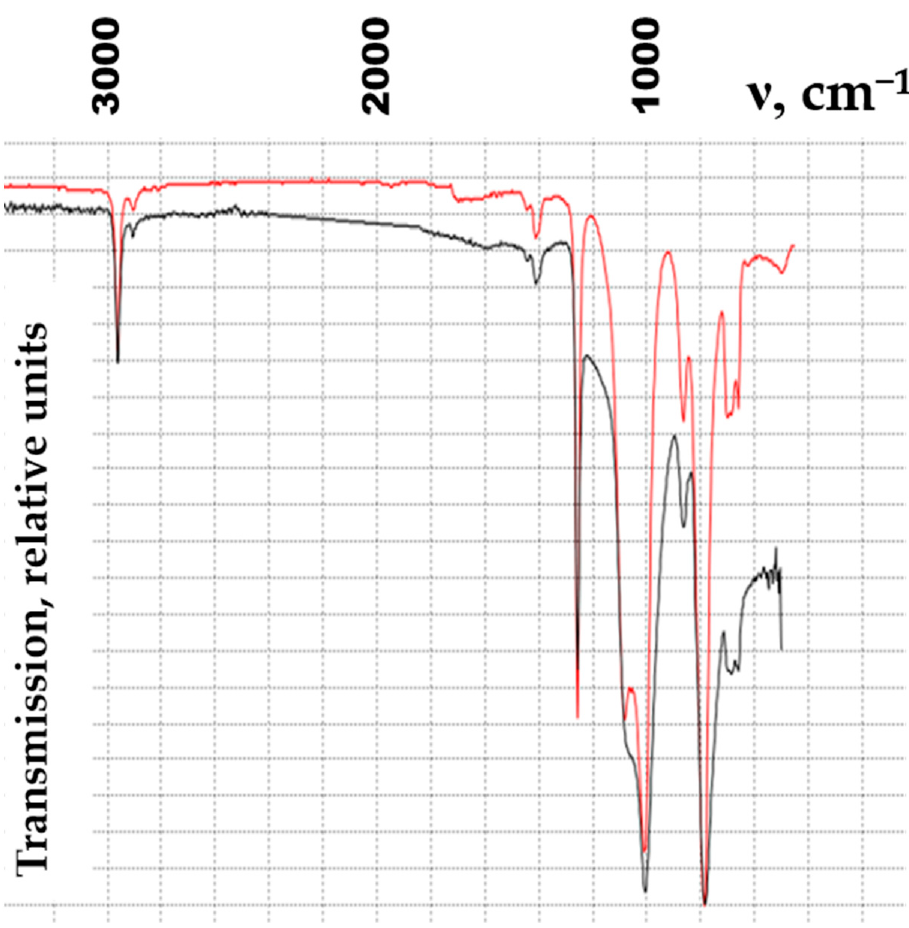
Figure 3. IR spectra of CO and NCO 1.